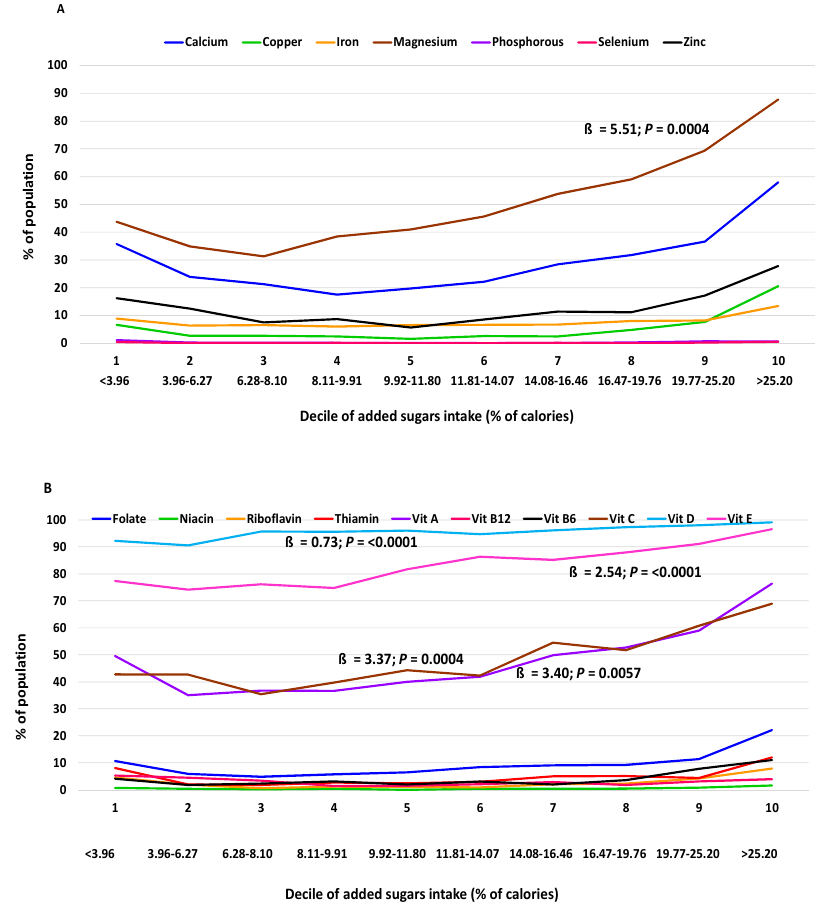
Figure 2. Percentage of adults 19–50 y (NHANES 2009–2014) with micronutrient intakes below the EAR for ( A ) minerals and ( B ) vitamins per decile of added sugars intake (% of calories) averaged across two days of intake using regression analysis (ß: regression coefficient). Association deemed significant at p < 0.01. EAR, Estimated Average Requirement; Vit, vitamin.